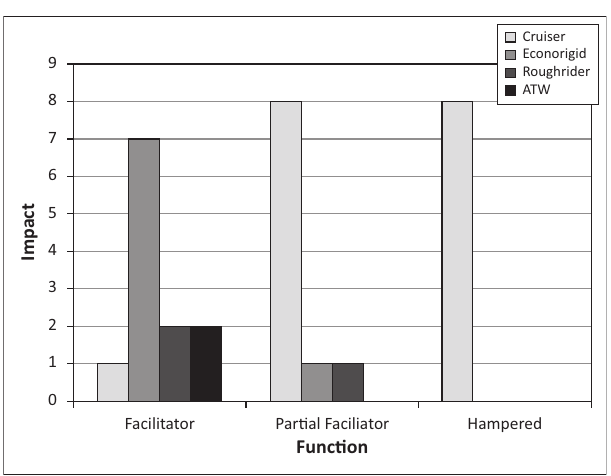
FIGURE 2: Impact of type of wheelchair on function as determined by the wheelchair specification checklist.